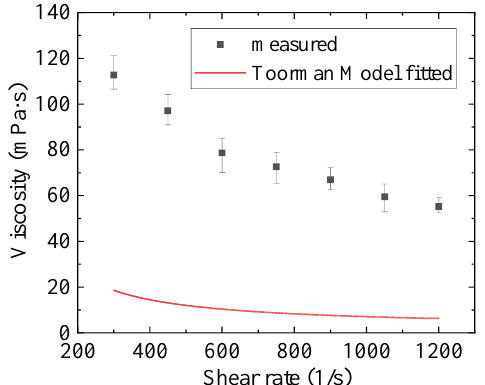
Figure A9. Toorman model steady-state fitting.